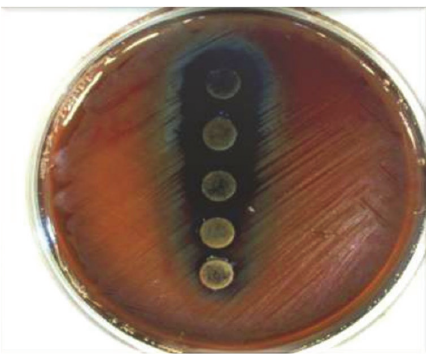
Figure 4: The effects of aqueous extracts of Juglans regia bark against S. sanguis